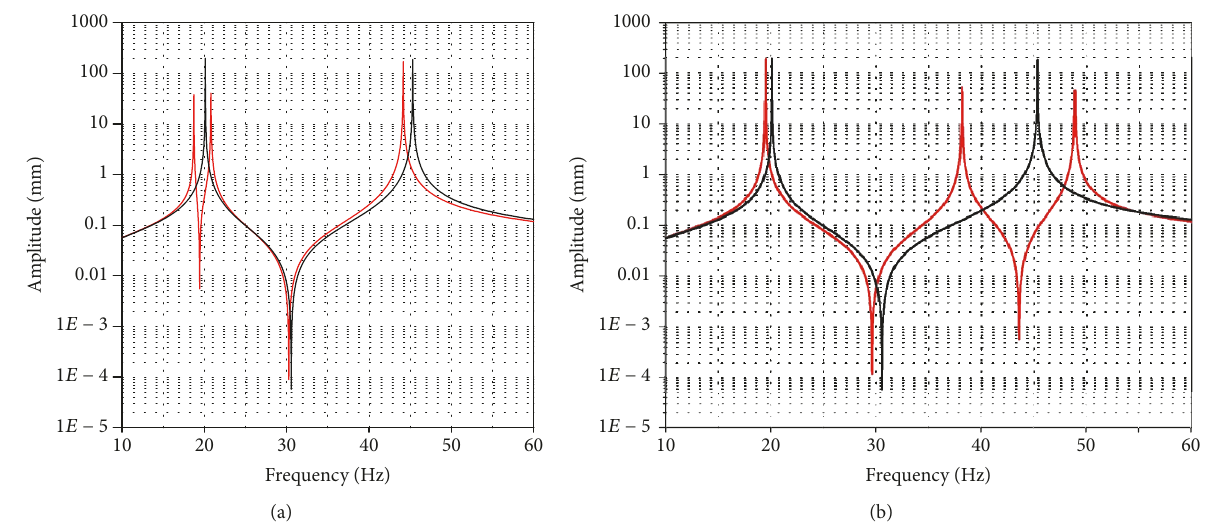
Figure8:Normalizedmagnitudeoftheprimarystructure:(a)withthebendingTMDand(b)withthetorsionTMD(Key:blackline,Primary: red line, TMD.).